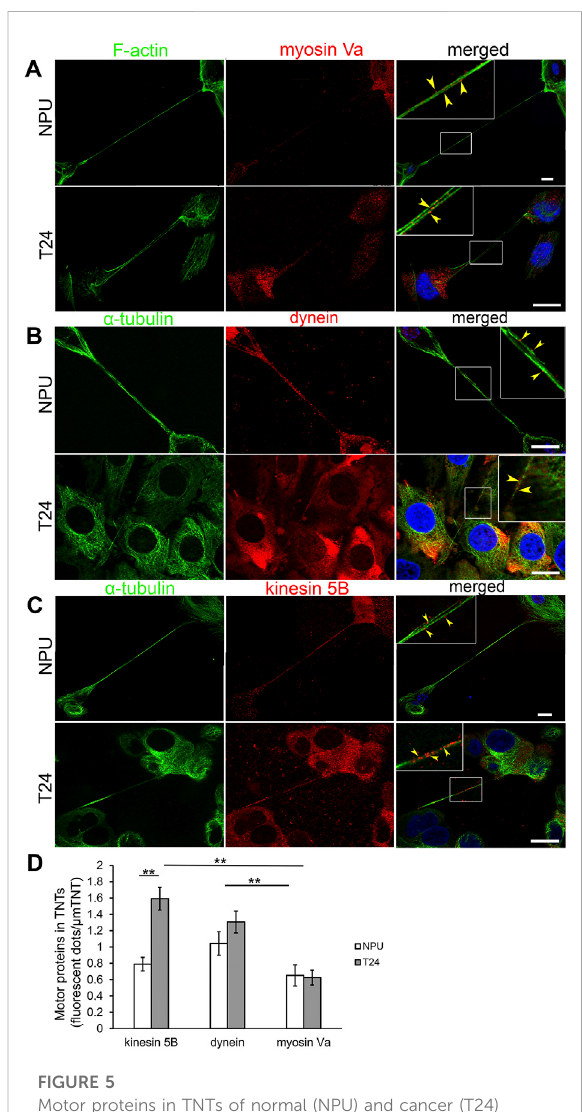
FIGURE 5 Motor proteins in TNTs of normal (NPU) and cancer (T24) urothelial cells. NPU and T24 cells contain TNTs with myosin Va (A) , dynein (B) , and kinesin 5B (C) along with F-actin or α -tubulin. The colocalization between motor proteins and cytoskeletal elements in TNTs (yellow arrowheads) from the insets in the merged images are magni fi ed in the corners. The nuclei were stained with DAPI. Scale bars: 20 μ m (D) Quanti fi cation of fl uorescent dots of motor proteins (arbitrary units) per μ m of TNT (mean ± SEM; NPU: kinesin, n = 17; dynein, n = 19; myosin, n = 16; T24: kinesin, n = 10; dynein, n = 13; myosin, n = 15; * p < 0.05, ** p <